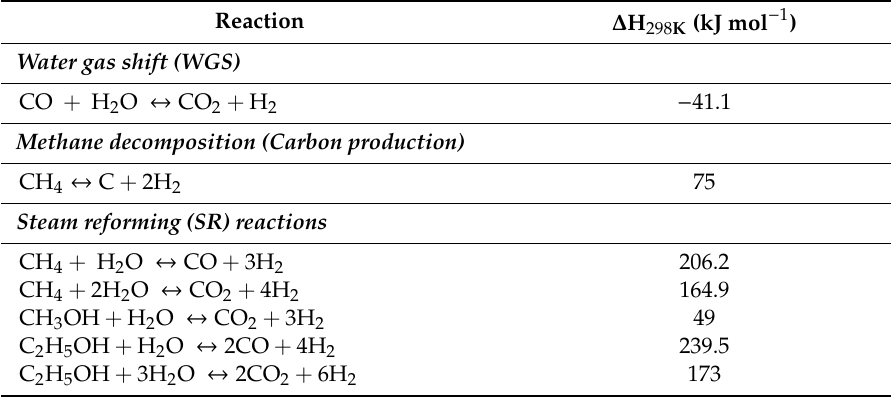
Table 1. Reactions considered for hydrogen production in membrane